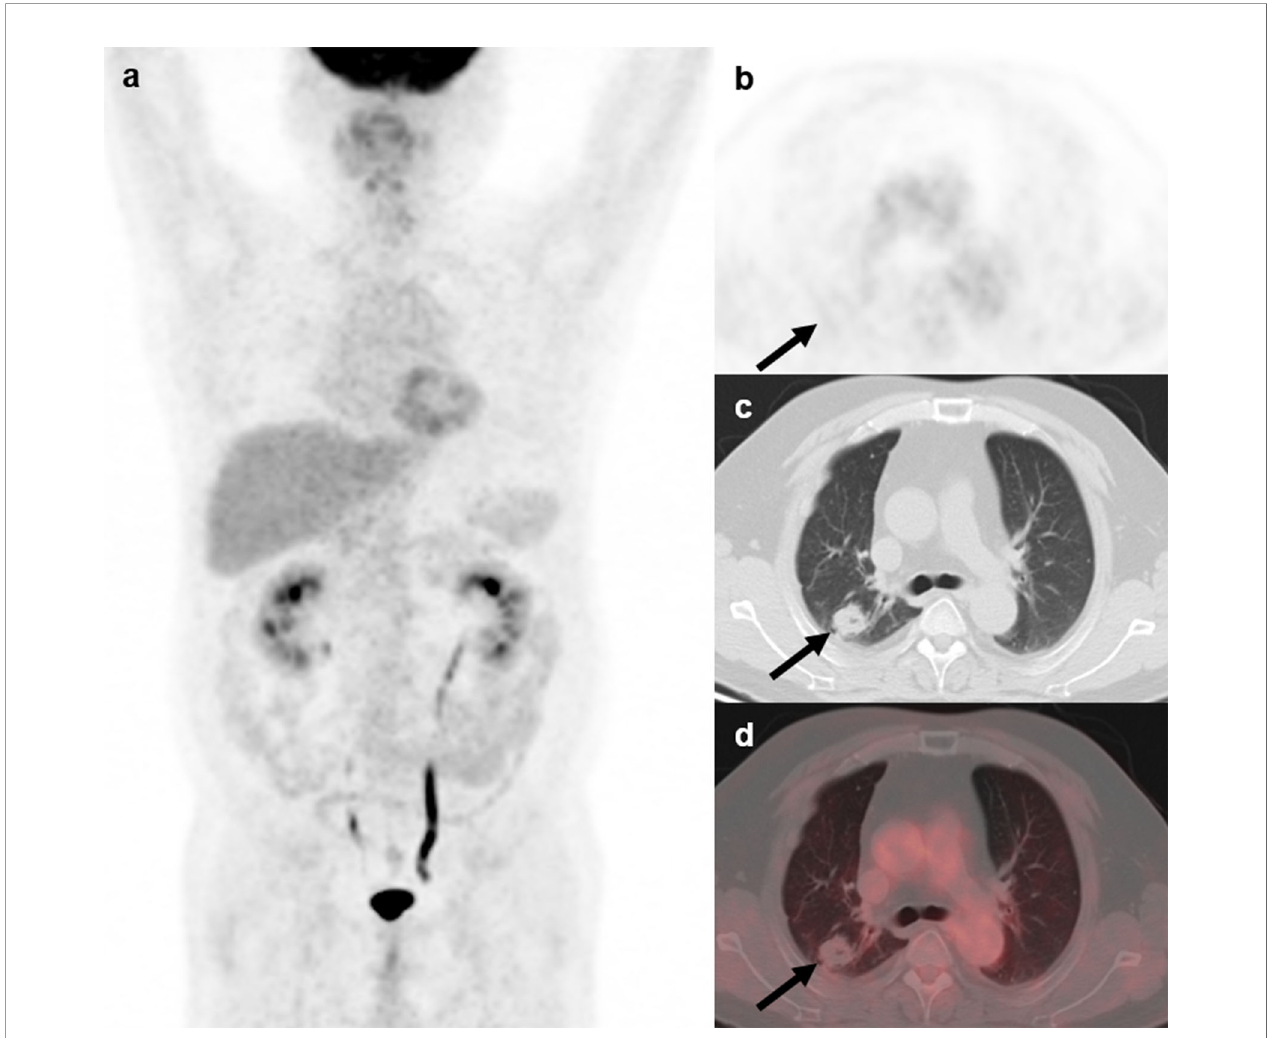
FIGURE 4 | 18 F-FDG PET/CT fi ndings in a representative case of aspergillosis (Patient, 4). A 39-year-old man diagnosed with ectopic Cushing syndrome underwent 18 F-FDG PET/CT to locate the possible ACTH-secreting tumor. 18 F-FDG PET/CT (A) showed a nodule in the right lung demonstrating slightly higher-than-background activity ( B – D ; arrows; SUV max , 1.0). Subsequent percutaneous lung biopsy con fi rmed the diagnosis of pulmonary